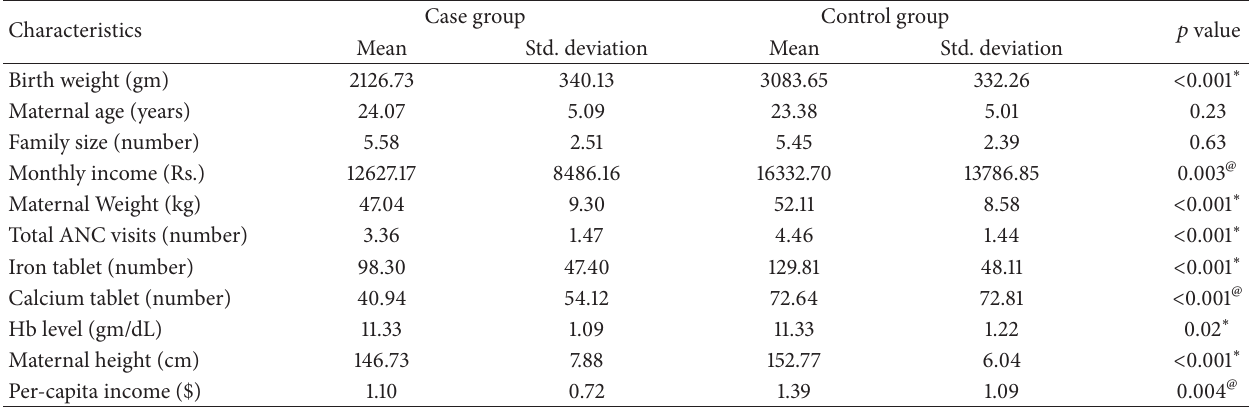
Table 1: Comparison of basic variables of mothers between cases and